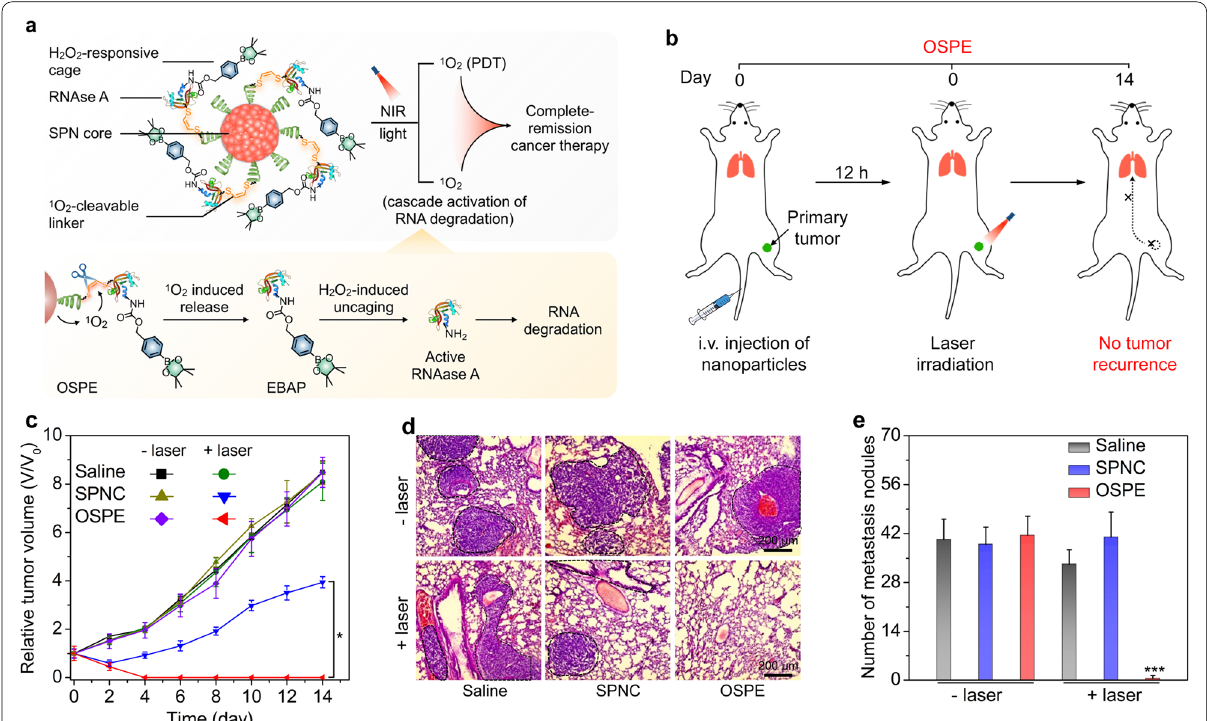
Fig. 5 a Illustration of the proposed mechanism for the photoactivated synergistic therapeutic action of organic semiconducting polymer pro-nanoenzyme (OSPE) including PDT and intracellular RNA degradation. b Schematic illustration of OSPE-mediated complete inhibition of tumor growth and metastasis. c The tumor growth curves in 4T1 tumor-bearing mice. d Histological hematoxylin and eosin staining of pulmonary metastatic tumors in 4T1 tumor-bearing mice. Tumors were indicated by the black dashed curves. e Quantitative analysis of pulmonary metastatic nodules in different treatment groups. Reproduced with permission from [77]. Copyright 2019, American Chemical